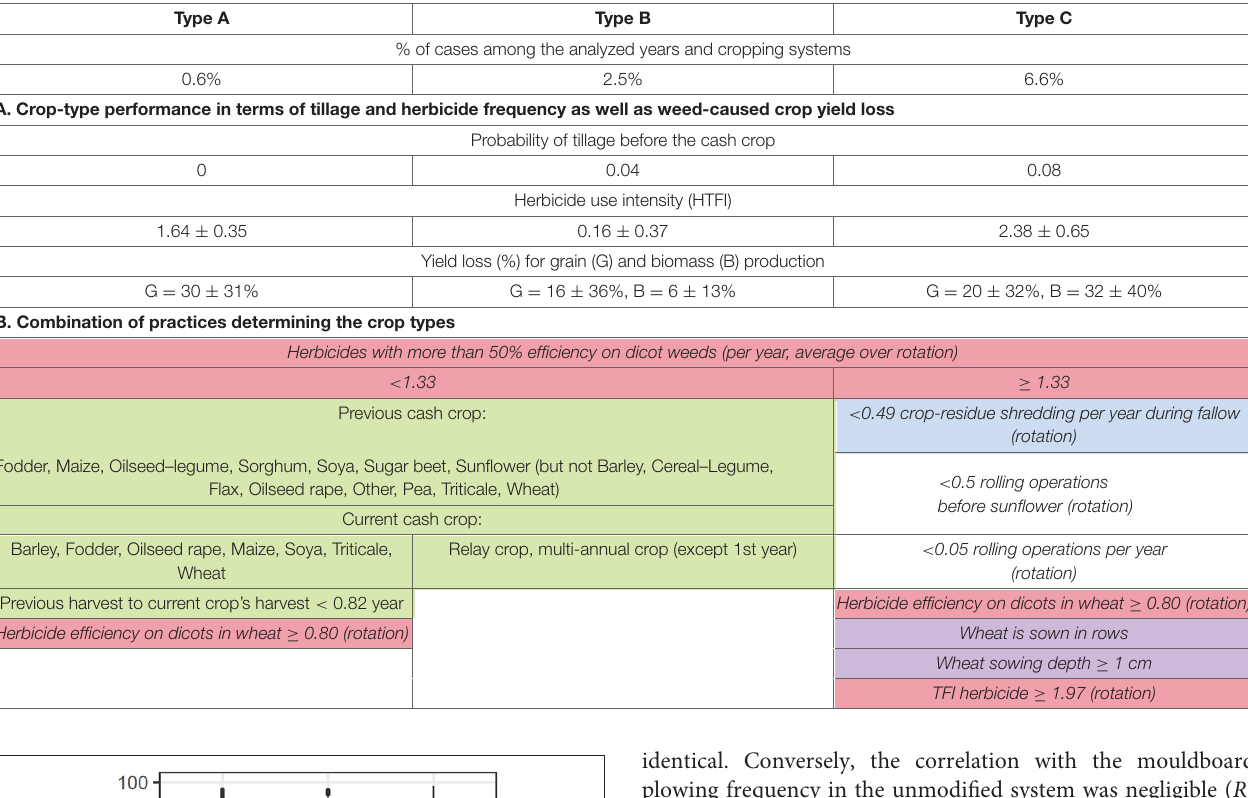
TABLE 2 | Typology of tillage-free crops among the 395 recorded cropping systems, based on a classification and regression tree. Discriminating practices are ranked from the most influential at the top to the least influential at the bottom. Cell colors distinguish variables in relation to rotation (green), herbicides (red), sowing (purple), crop-residue shredding, mowing and topping (blue), and others (white). Italics show practices averaged over rotation. TFI, Treatment Frequency Index (1 = one commercial product applied at the recommended dose over the whole field a given year).